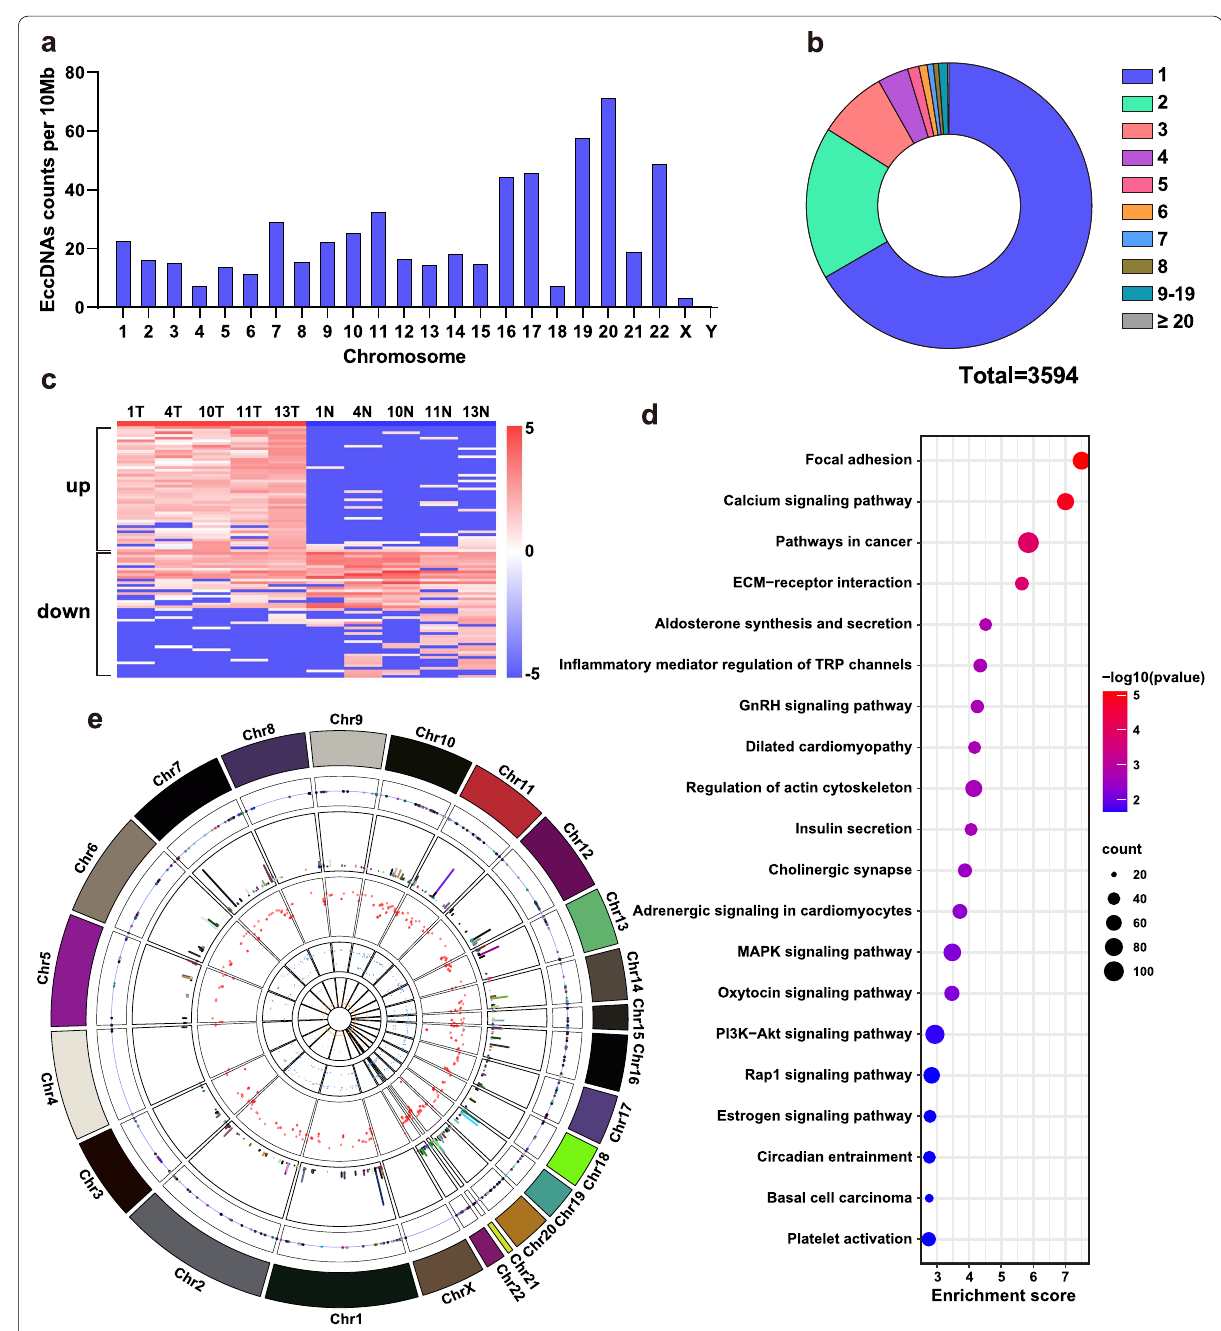
Fig. 2 Counts distribution, gene expression and chromosomal distribution of eccDNAs in the samples. a Histogram of the eccDNA frequency per 10 Mb in each chromosome. b Pie chart of the percentages of genes ( n 3594) shedding different amounts of eccDNAs. c Heatmap consisting of = the logarithm of the normalized values of the highly and lowly expressed genes in each tumor group and N ( n 47 in high and low expression = respectively). d Scatter plot of enriched KEGG pathways statistics for genes (n 3594) contained in eccDNAs in tumor group. e Circos plot of = chromosomal distribution and expression levels of high-expressed eccDNAs in tumor group. Concentric circles are, in order from outside to inside: human chromosomes (chr1-chrX), after which the x-axis of all circles is chromosomal coordinate; chromosomal localization of eccDNAs; the basemean of the genes, with the y-axis showing the expression level; Rainfall plot of the degree of gathering of eccDNAs, and the y-axis corresponds to the minimal distance of the region to its two neighboring regions; the foldchange of the genes; the P value of the